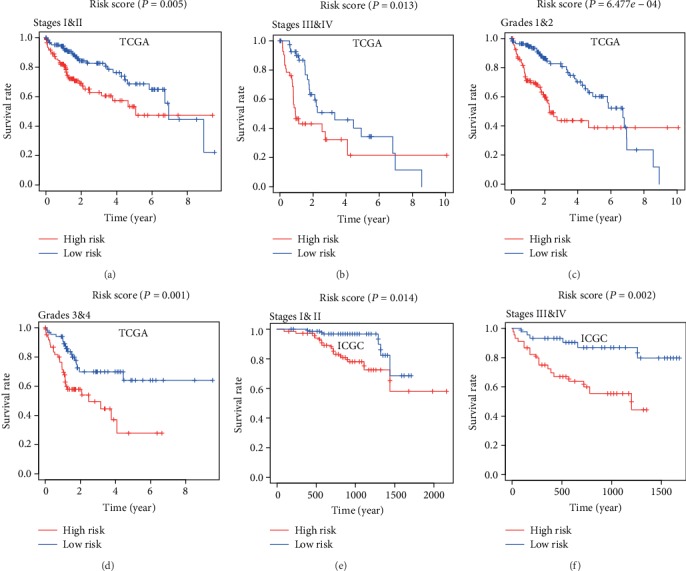
Survival analysis of the risk score in different pathological subgroups of HCC patients. The three-gene based risk score is a promising marker for overall survival in pathological subgroups of stages I and II (a), stages III and IV (b), grades l and 2 (c), grades 3 and 4 (d) in the TCGA dataset and stages I and II (e), stages III and IV (F) in the ICGC dataset.